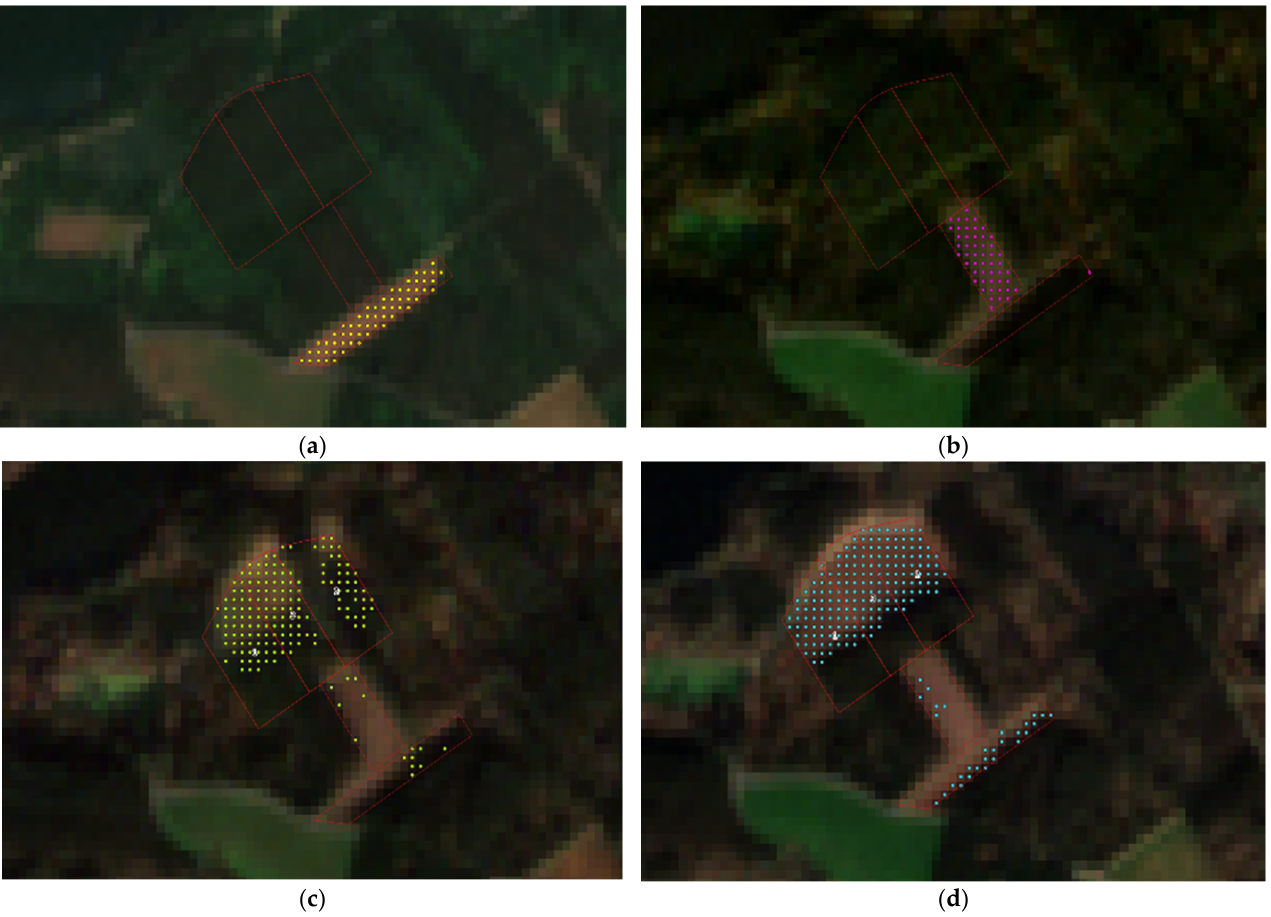
Figure 9. Cut detection in four plots of E. globulus with different ages and felling shifts. Current high-resolution RGB image with the location and dates of the pixel drops that were identified as cuts during the analysis period. Cutting start date: ( a ) 2019-07-12; ( b ) 2019-12-04; ( c ) 2020-01-25; ( d )